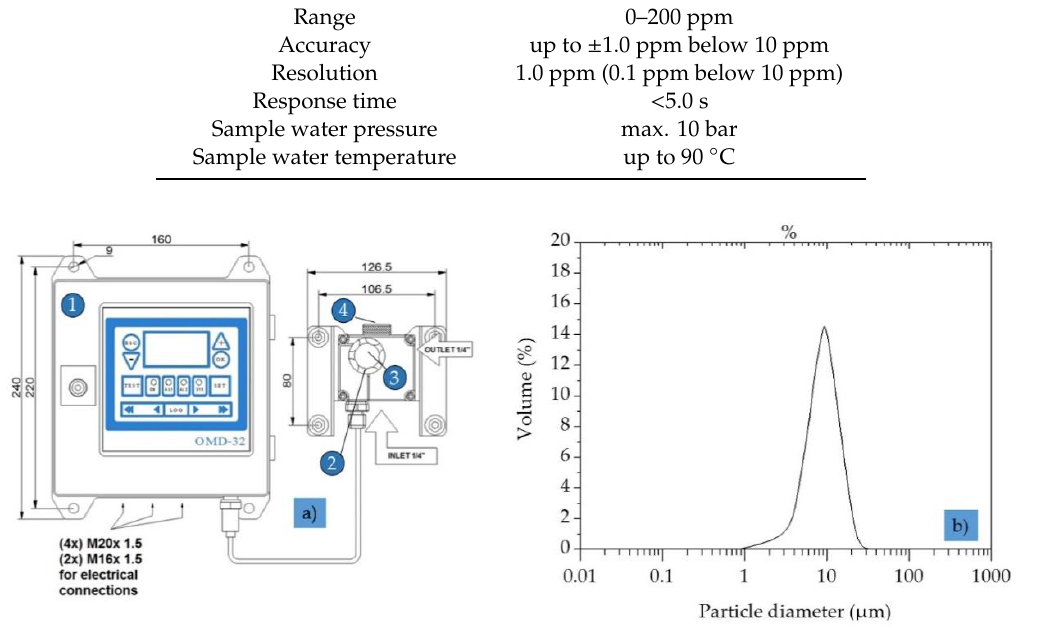
Figure 4. Oil-in-water sensor to measure the particle size distribution. ( a ) Oil-in-water sensor OMD-32: 1 = computer; 2 = measuring cell; 3 = desiccator cap; 4 = head screw; ( b ) particle size distribution in the prepared OMS. Table 3. Characteristics of oily model solutions (OMSs) and tank-dewatering produced water (TDPW) compared to oilfield produced water (PW). Conductivity data for the oilfield PW were not available (n.a.).